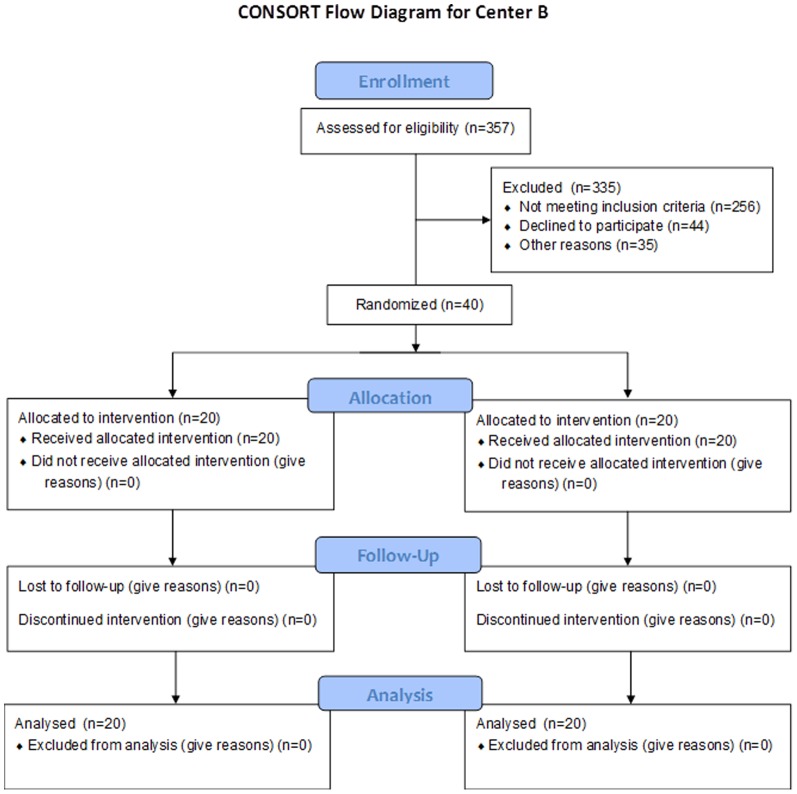
CONSORT diagram for center B.Assessment of Eligibility and Inclusion in the Inhaled Nitric Oxide for Attenuating Liver Allograft Injury Study at Center B.